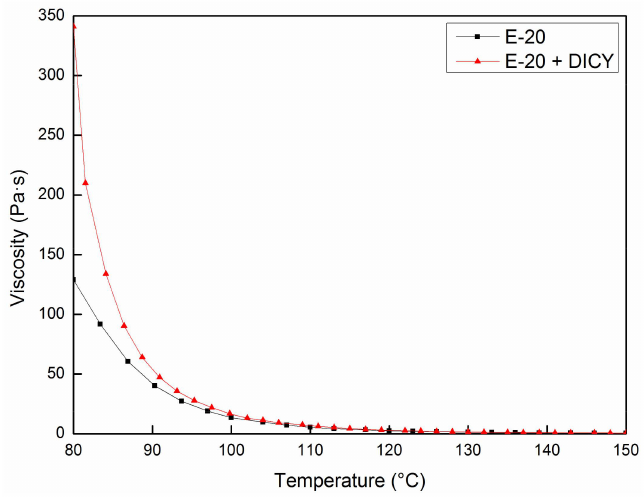
Figure 2. Viscosity–temperature curves of E-20 and the mixed